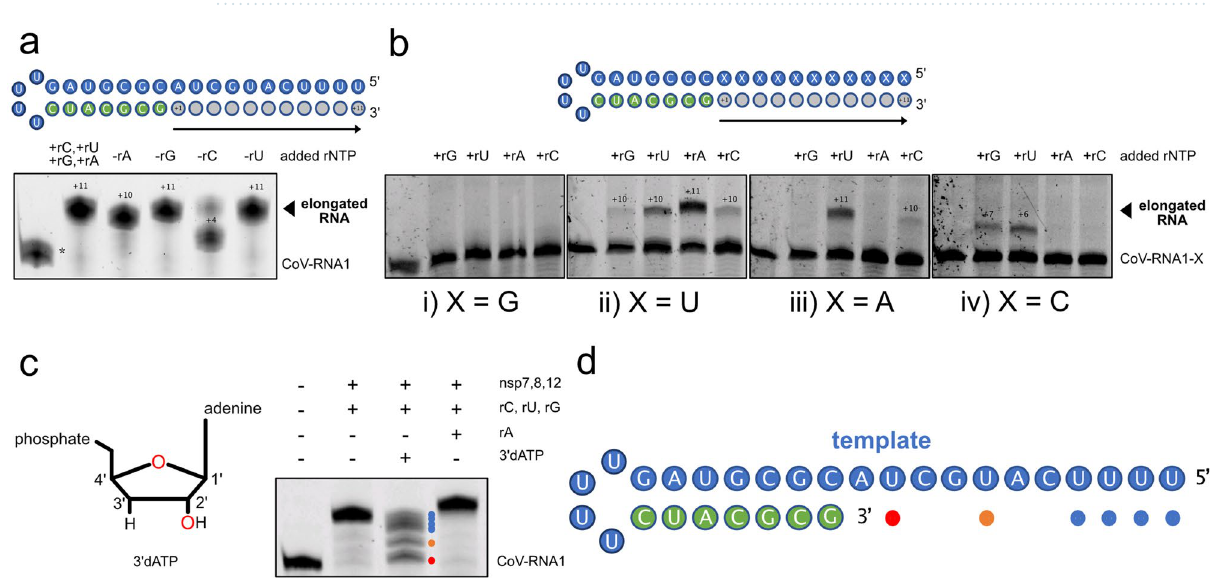
Figure 3. Nsp7,8,12 readily incorporates 3 ′ dATP during extension, and lacks fidelity during extension under starved conditions. ( a ) The elongation products of CoV-RNA1 that are generated by nsp7,8,12 in the absence of a single nucleotide. The asterisk corresponds to an n + 1 RNA contaminate that was unable to be removed during substrate purifcation. ( b ) The extended products (or lack thereof) of nsp7,8,12 on uniform-nucleotide CoV- RNA1-X substrates in the presence of rNTPs. ( c ) The RdRp incorporates 3 ′ dATP during elongation, resulting in stalled RNA products. ( c , d ) The secondary structure of the CoV-RNA1 substrate with positions of stalled RNA products (formed by incorporation of 3 ′ dATP) marked by colored